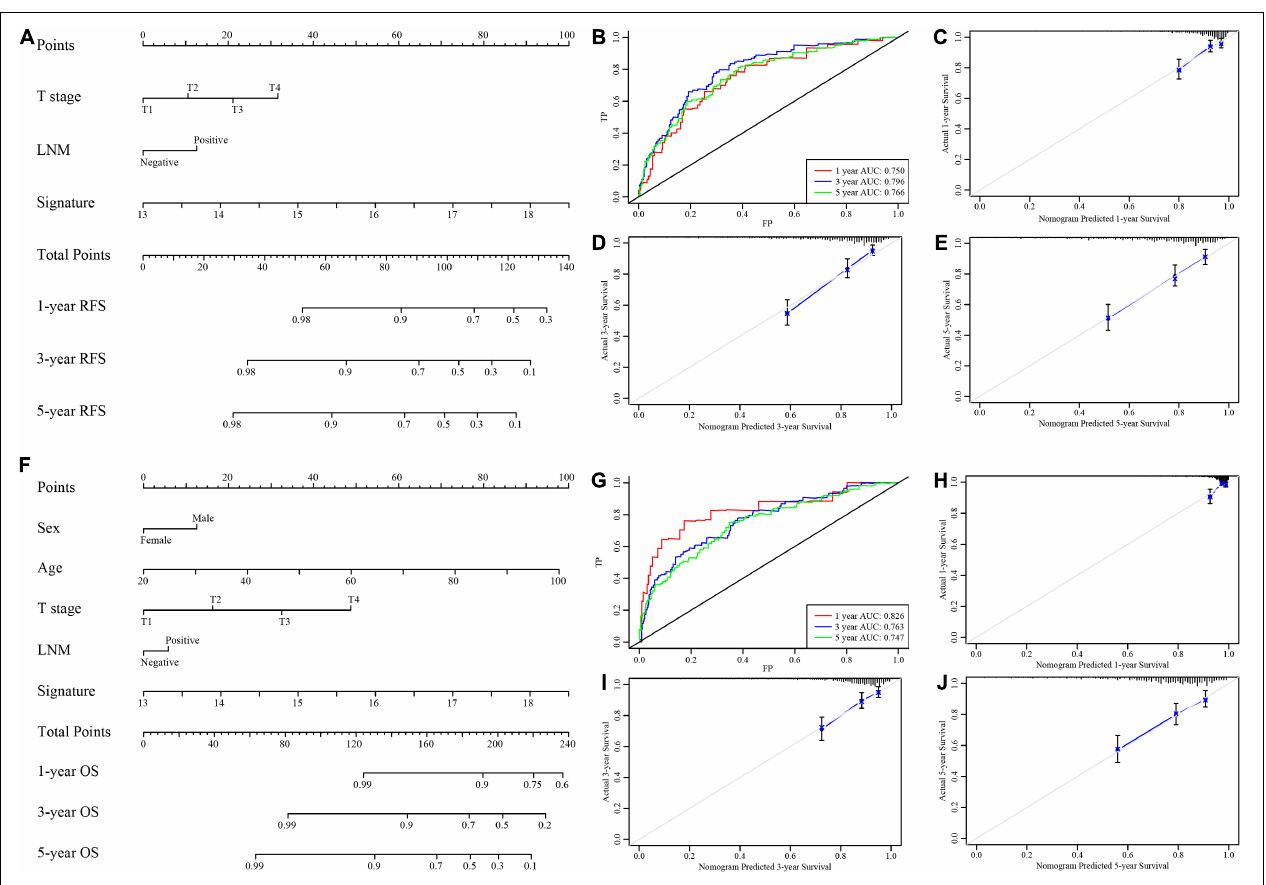
FIGURE 6 | Nomograms to predict 1 − , 3 − , and 5-year RFS and OS in the GSE39582 set. (A) Nomogram for predicting the 1 − , 3 − , and 5-year RFS time in CRC patients. (B) Time-dependent ROC curve for RFS. The AUC was assessed at 1 − , 3 − , and 5-year. (C–E) Calibration curve for the prediction of 1 − , 3 − , and 5-year RFS. (F) Nomogram for predicting the 1 − , 3 − , and 5-year OS time in CRC patients. (G) Time-dependent ROC curve for OS. The AUC was assessed at 1 − , 3 − , and 5-year. (H–J) Calibration curve for the prediction of 1 − , 3 − , and 5-year